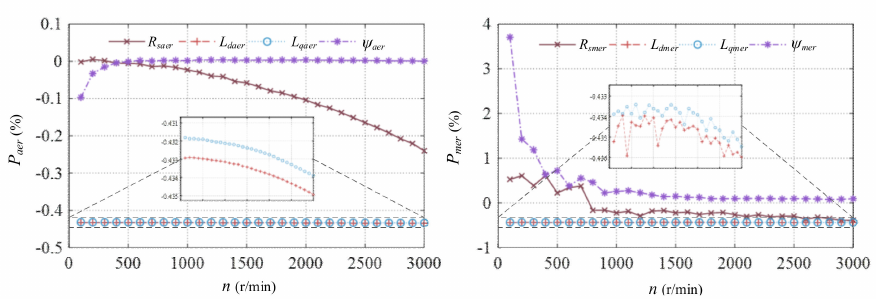
Figure 10. Identification accuracy at different velocities.